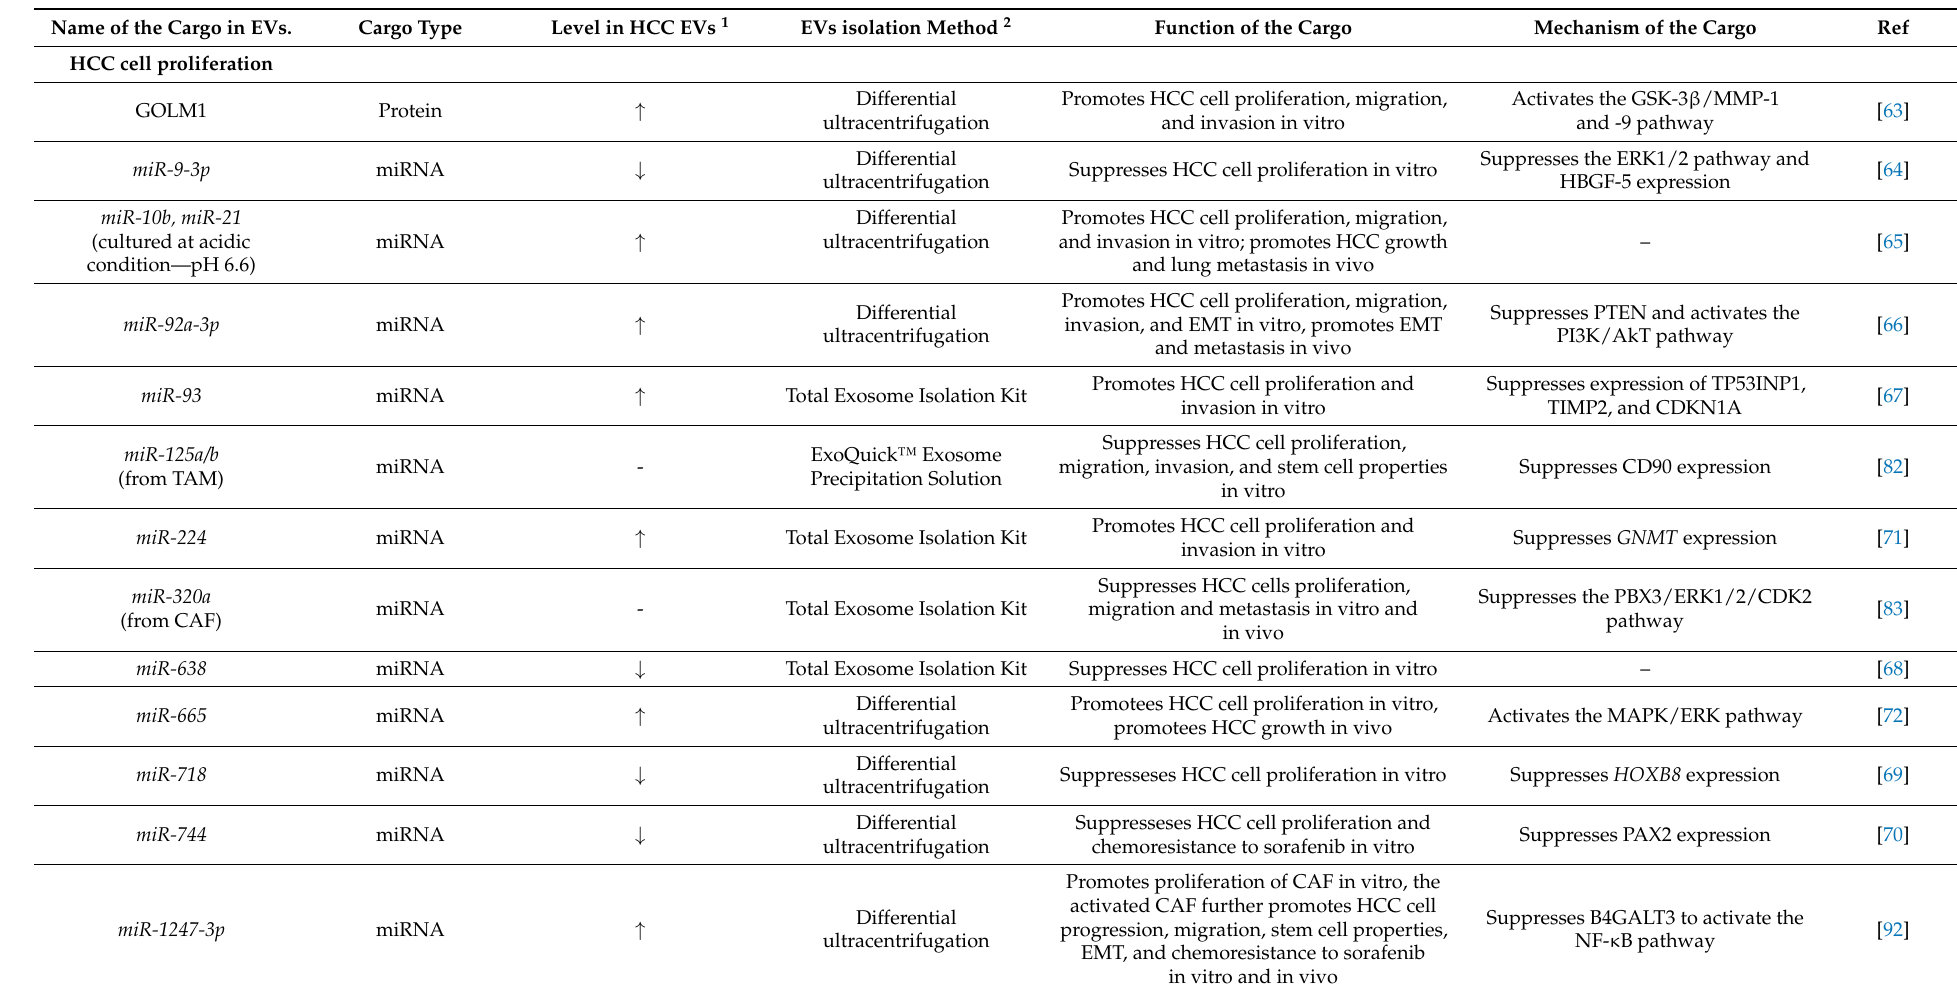
Table 1. EVs as mediators of HCC